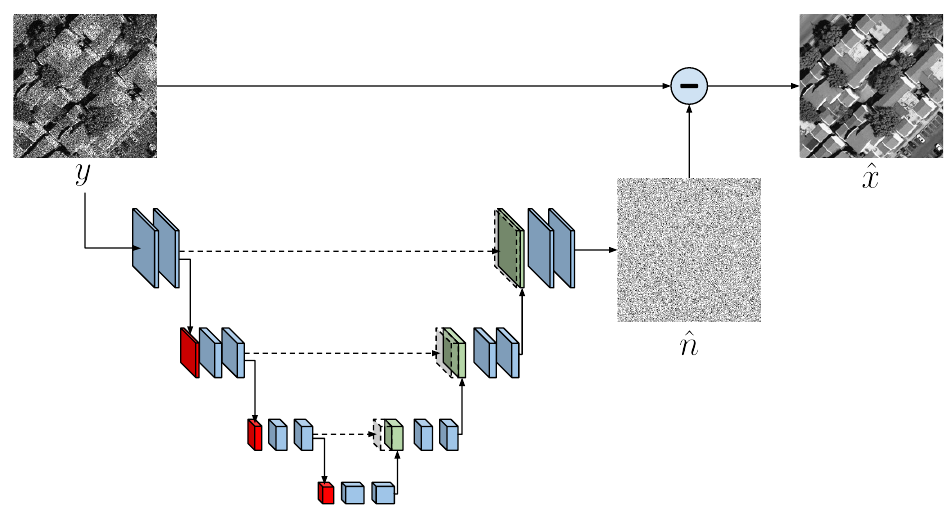
Figure 5. Despeckling